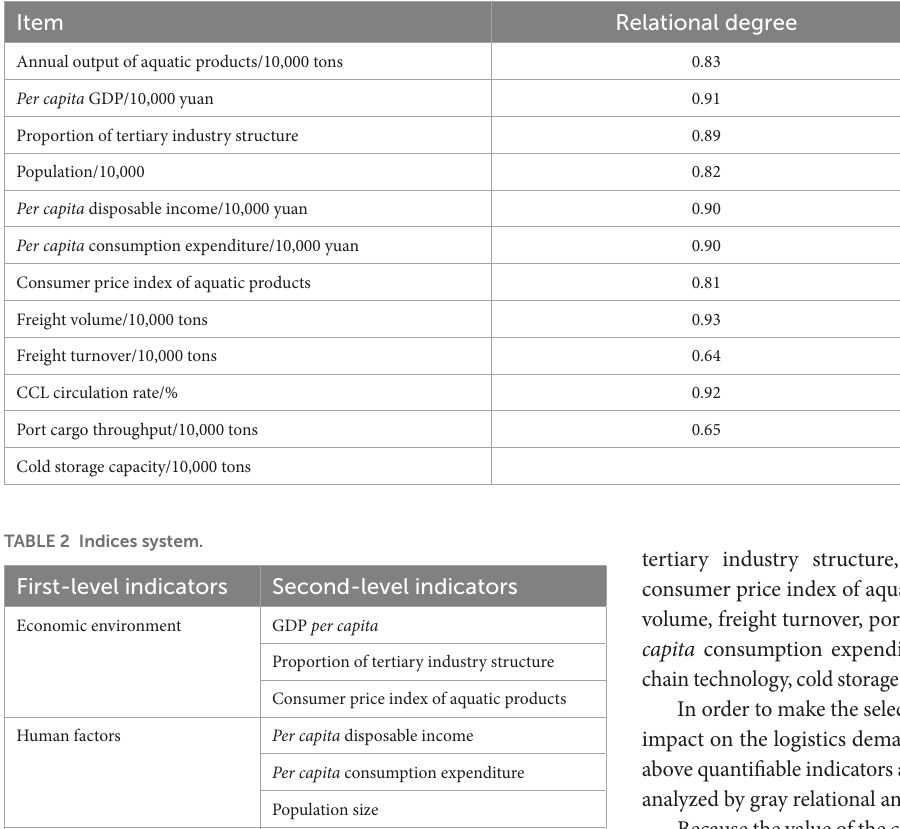
TABLE 1 Gray relational degree of the cold chain.